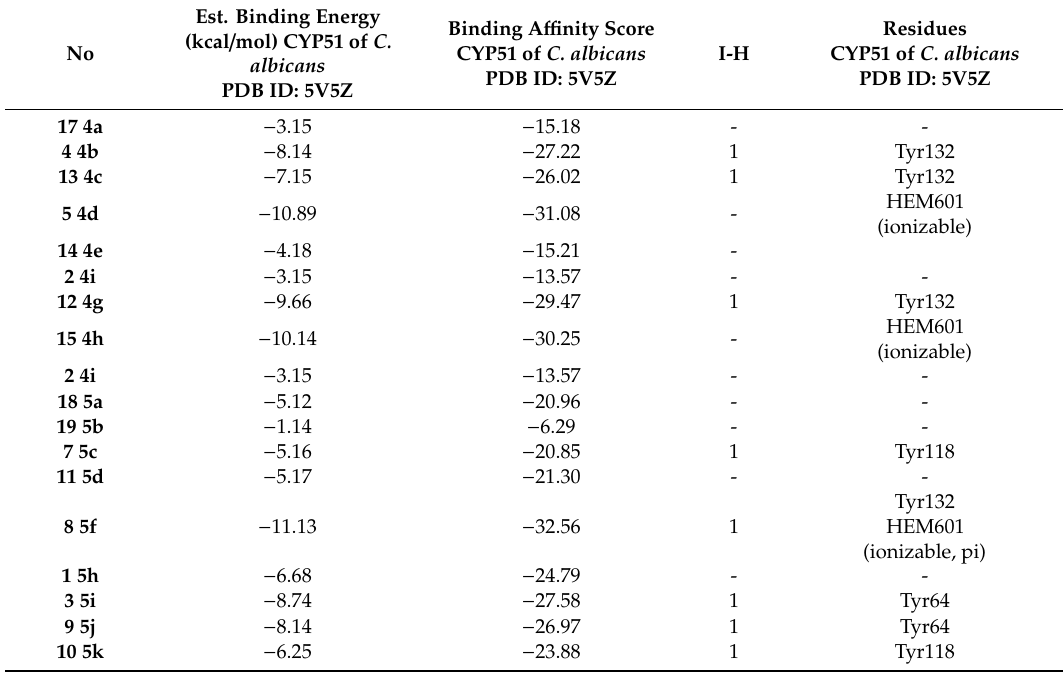
Table 5. Molecular docking binding a ffi nities for antifungal targets.